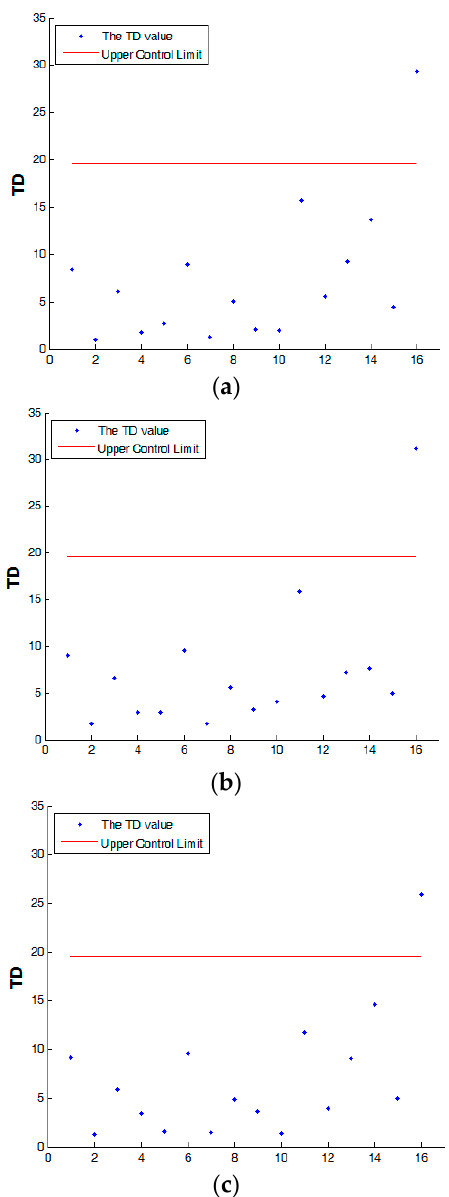
Figure 9. Detect the abnormal profiles using the sum of sine function with the 15 in-control profiles. ( a ) Detecting the abnormal profile 1; ( b ) Detecting the abnormal profile 2; and, ( c ) Detecting the abnormal profile 3.